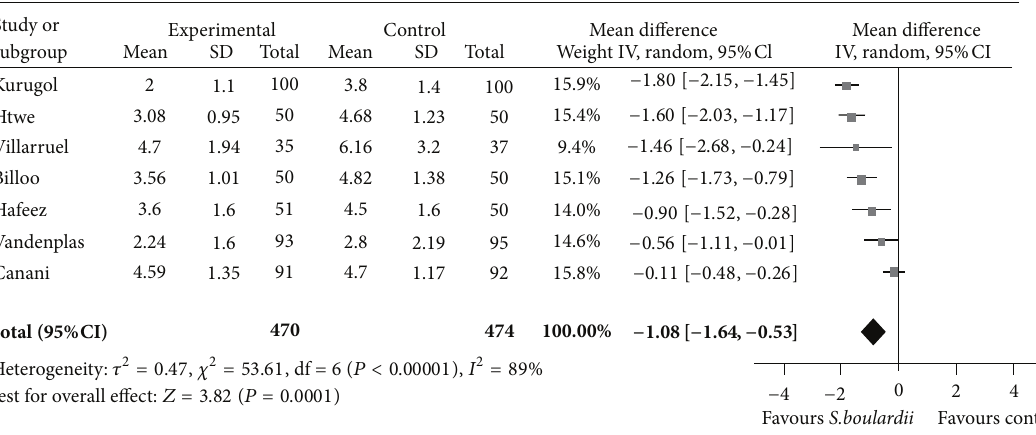
Figure 6: Efficacy of probiotics: weighted mean difference in the duration of diarrhoea between S. boulardii and control groups (days). Negative values indicate that the duration of diarrhoea was shorter in the S. boulardii group than in the control group. Reproduced with permission from Szajewska and Sk´orka 2009 [68].